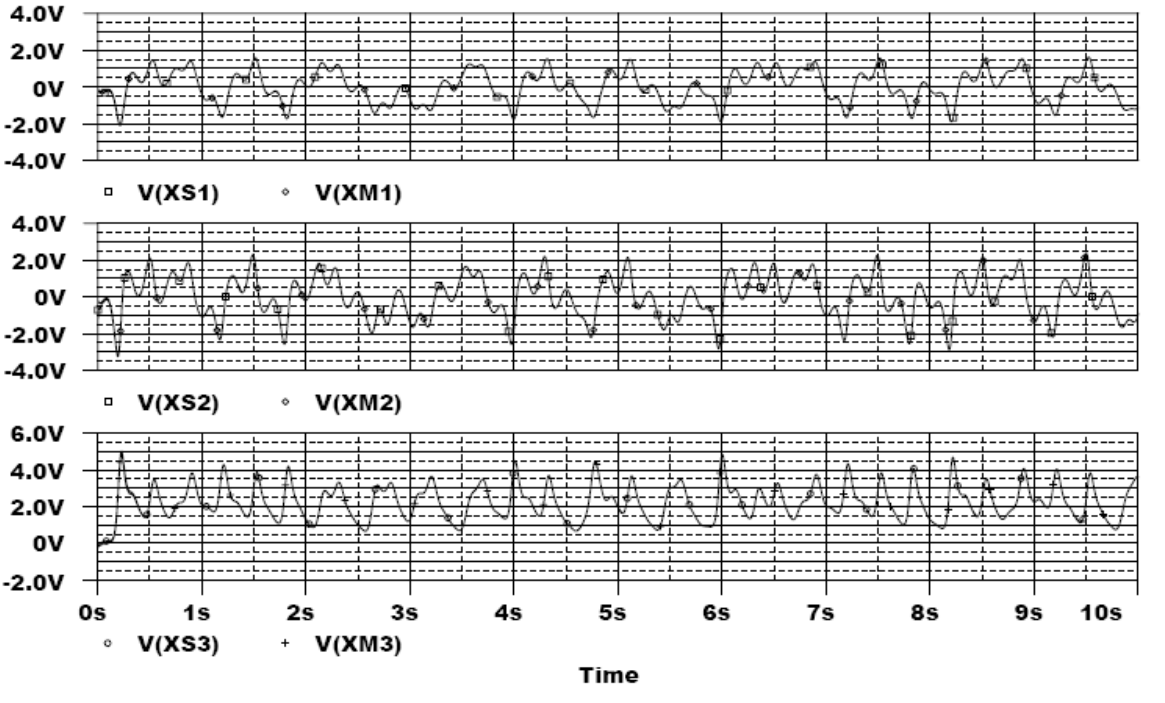
and state x . m s